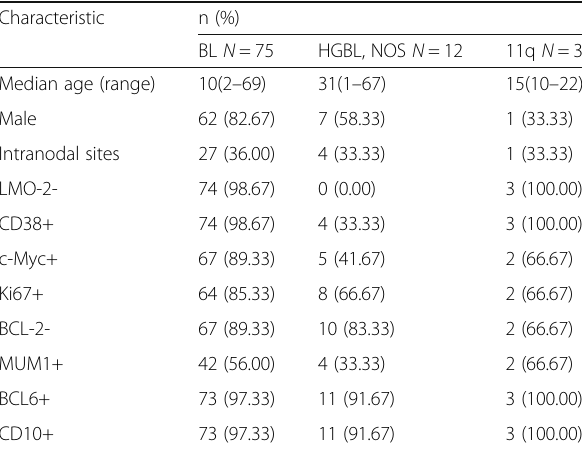
Table 1 The clinicopathologic features and the expression of immunohistochemical markers in Burkitt lymphoma, High-grade B-cell lymphoma, not otherwise specified and Burkitt-like lymphoma with 11q